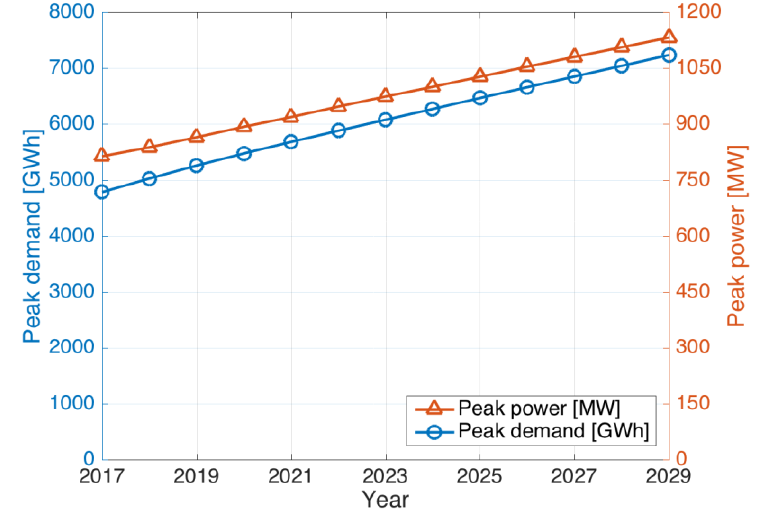
Figure 1. Power supply and demand in Jeju (2017 – 2029).